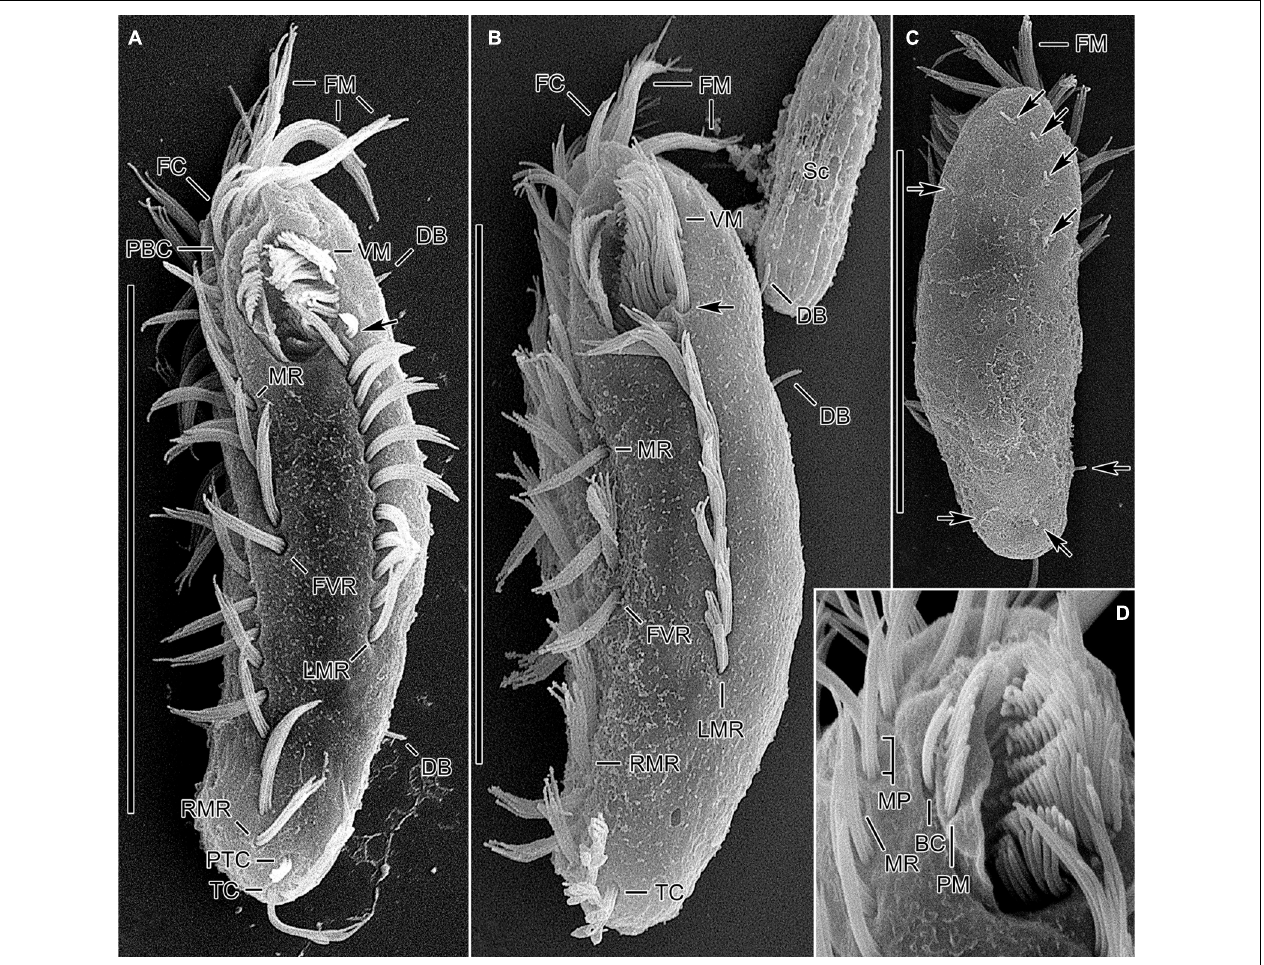
FIGURE 4 | Tunicothrix halophila n. sp. in the scanning electron microscope. (A,B) Ventral and lateral view showing typical morphology. Arrows denote anteriormost left marginal cirrus curved leftward. (C) Dorsal view showing highly reduced dorsal bristles (arrows). (D) Oral apparatus. BC, buccal cirrus; DB, dorsal bristles; FC, frontal cirri; FM, frontal adoral membranelles; FVR, frontoventral row; LMR, left marginal row; MP, midventral pair; MR, midventral row; PBC, parabuccal cirrus; PM, paroral membrane; PTC, pretransverse cirri; RMR, right marginal row; Sc, unidentified scuticociliate; TC, transverse cirri; VM, ventral adoral membranelles. Scale bars 30 µ